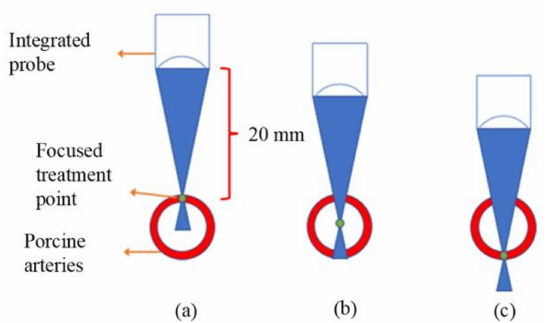
Figure 9. Schematic diagram of different focused treatment points: ( a ) the treatment focus on the superior wall of the blood vessel; ( b ) the treatment focus on the middle of the blood vessel; ( c ) the treatment focus on the inferior wall of the blood